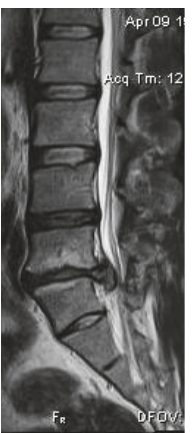
Figure 3: A 17-year-old male with an extensive descending disc herniaatL5-S1level,withrootimpingementandseveredegenerative endplate changes, on sagittal